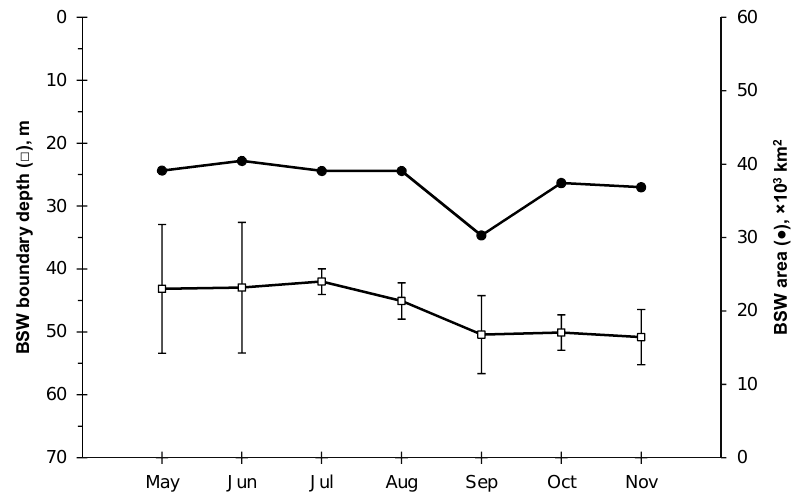
Fig. 5. Intra-seasonal variability (May–November) of the coverage (in × 10 3 km 2 ) of BSW (full circles) and the average depth of the isopycnal σ θ = 14 . 2kgm − 3 which represents the upper boundary of the BSW, for the same period (open squares). Error bars show 1 standard deviation.